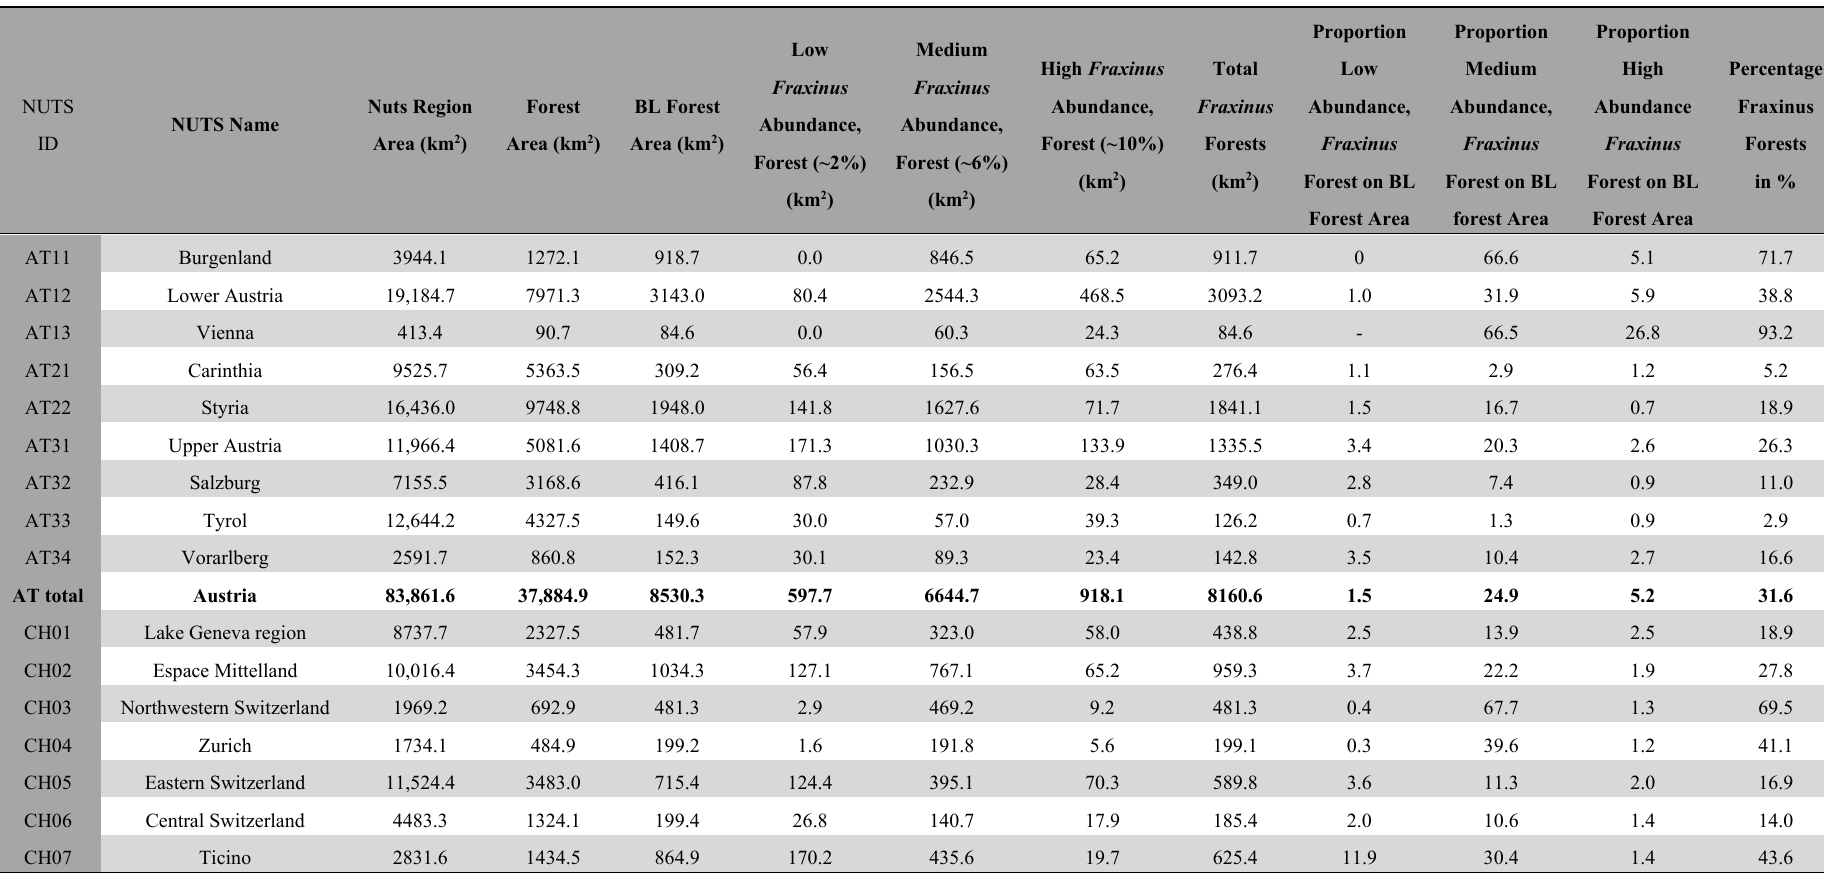
Table 2. Forest extent and distribution of Fraxinus excelsior in the NUTS2 (second-level Nomenclature of Units for Territorial Statistics) regions in the entire study region: Austria (AT), Switzerland (CH), South Germany (DE), South Tyrol (ITH), and Liechtenstein (LI). The total area of forest, broad leaved forests (BL) and the percentage of forested area of F. excelsior with different levels of abundance—low (~2%), medium (~6%) and high (~10%) are given. The total extent of Fraxinus forests and the proportions of different classes of Fraxinus forests on broad-leaved forest extent are also given. See Figure 3 for location of NUTS2